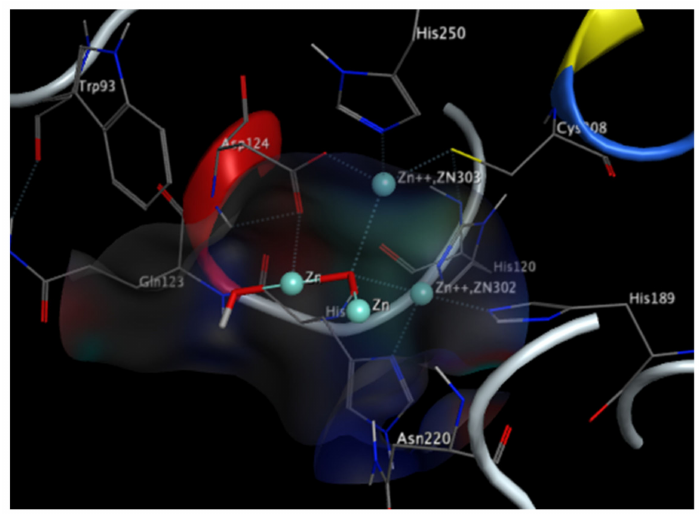
Figure 7. Three-dimensional binding mode of ZnO nanoparticles inside NDM-1 active site.